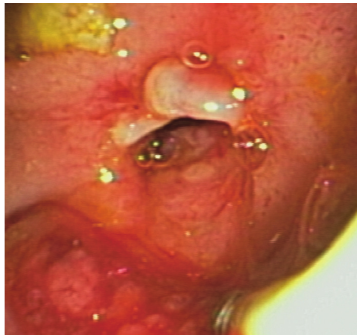
Figure 5: No signs of bleeding after metallic stent removal.